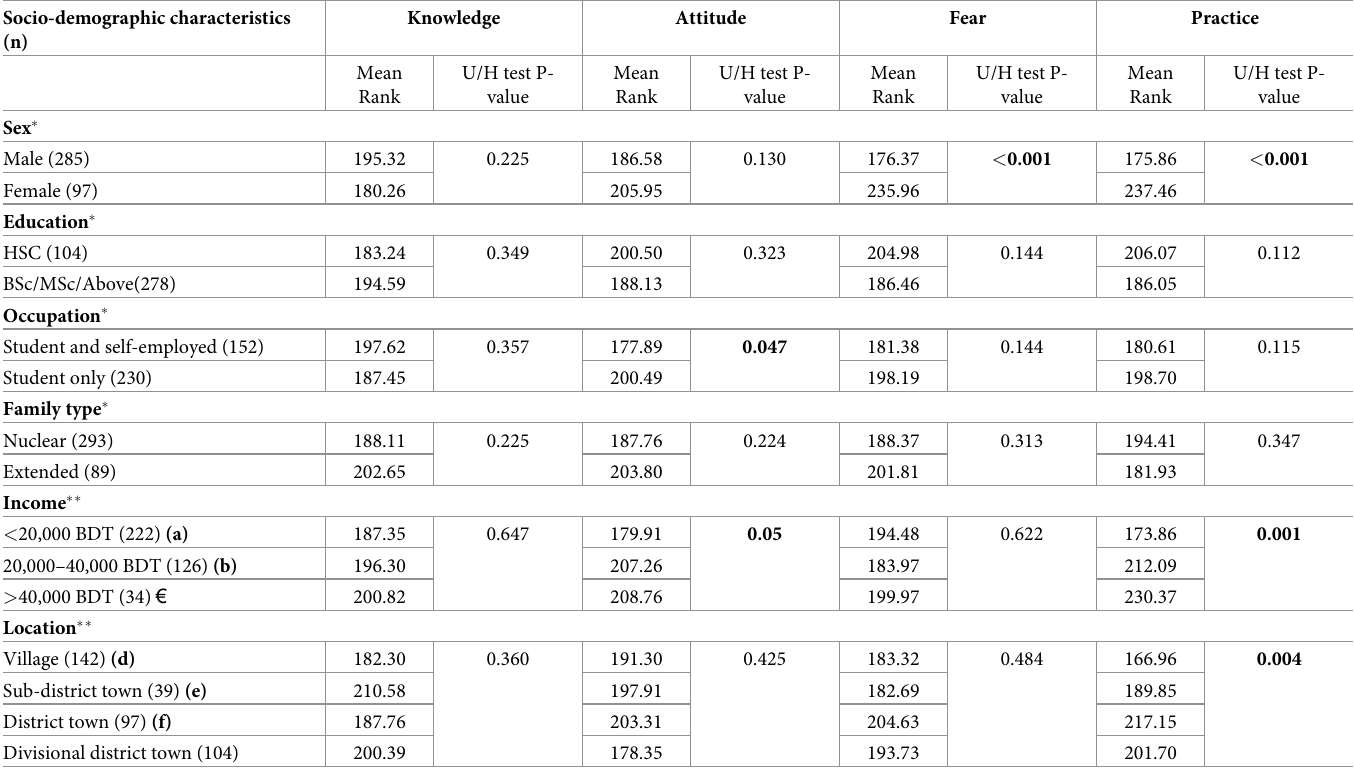
Table 4. Association of socio-demographic characteristics with knowledge, attitude, fear, and practice